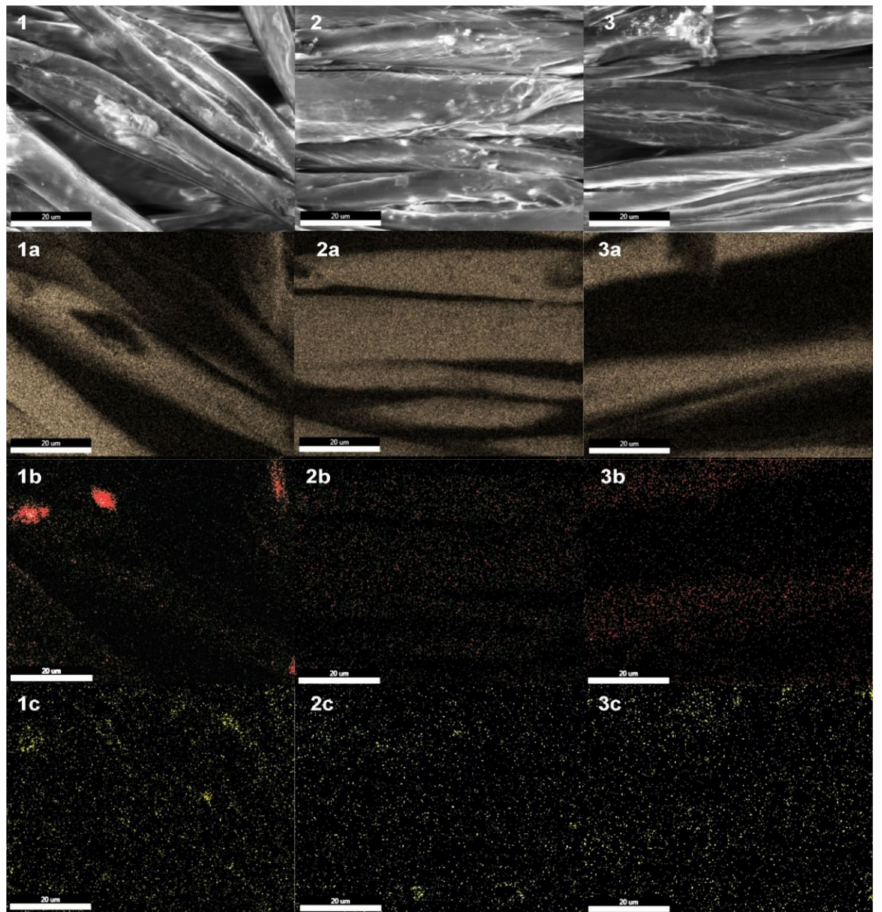
Figure 3. EDX-mapping of modified terry fabric, 1—modified fabric before washing, 2—modified fabric after 15 washings and 3—modified fabric after 30 washings; ( a )—carbon, ( b )—zinc and ( c )—titanium.